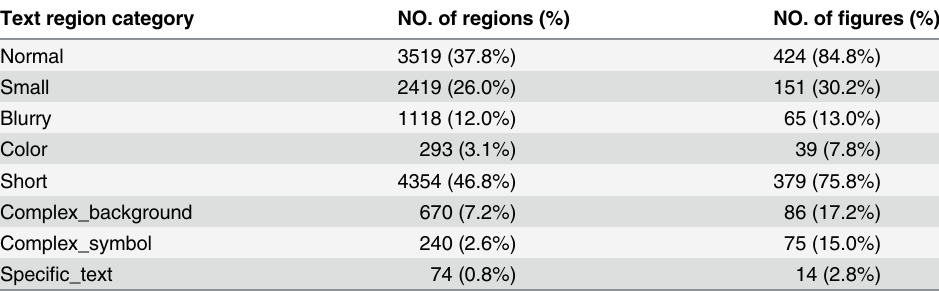
Table 2. Statistics of text (word) regions and figures with different